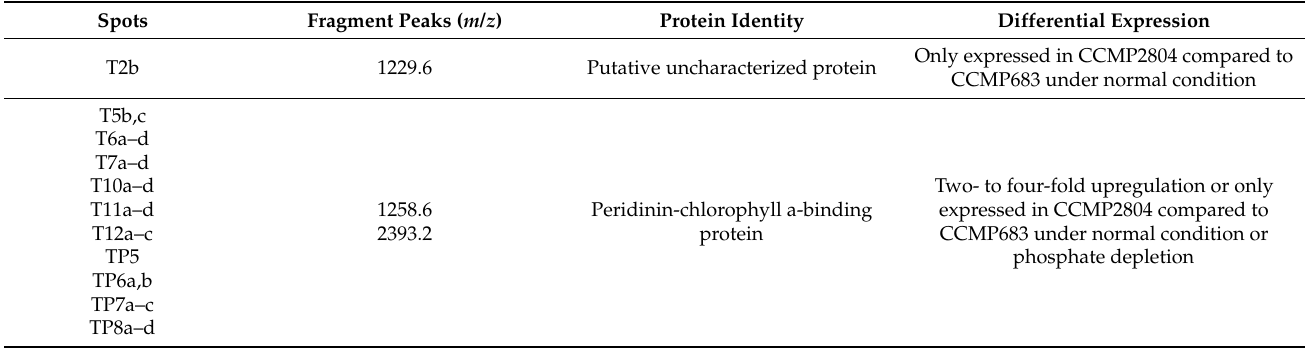
Table 1. Summary of identified proteins after de novo peptide